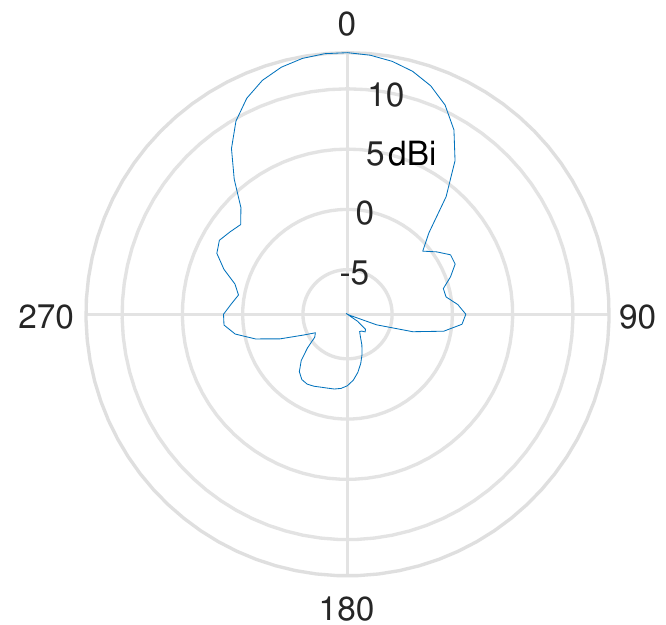
Figure 5. Measured H-plane radiation pattern of the 868 MHz Yagi-Uda